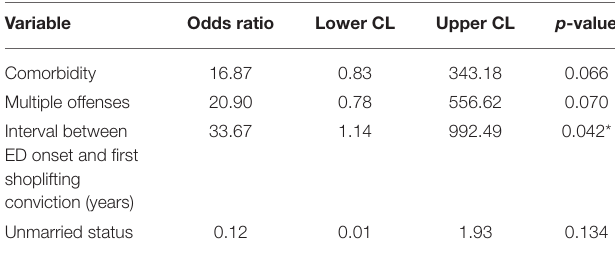
TABLE 2 | Multiple logistic regression for the outcome variable of food-specific or non-specific shoplifting